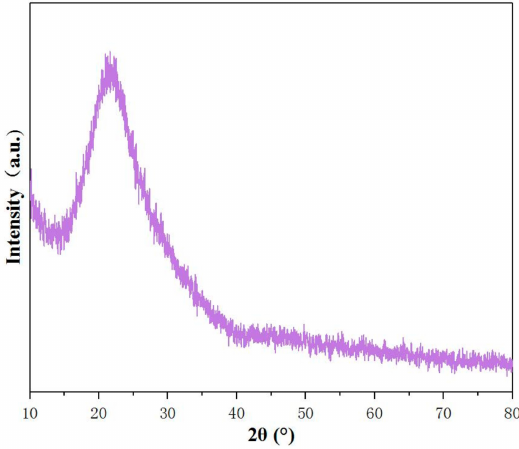
Figure 4. The XRD pattern of